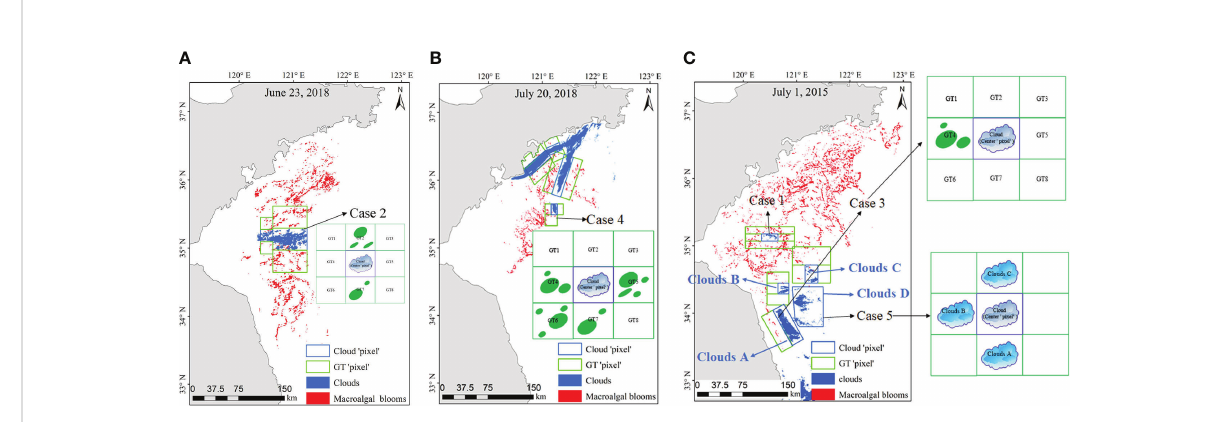
FIGURE 6 Application of the simple method for estimating macroalgae area under clouds under various scenarios. (A) The scenario of Case 2. (B) The scenario of Case 4. (C) The scenarios of Case 1, Case 3 and Case